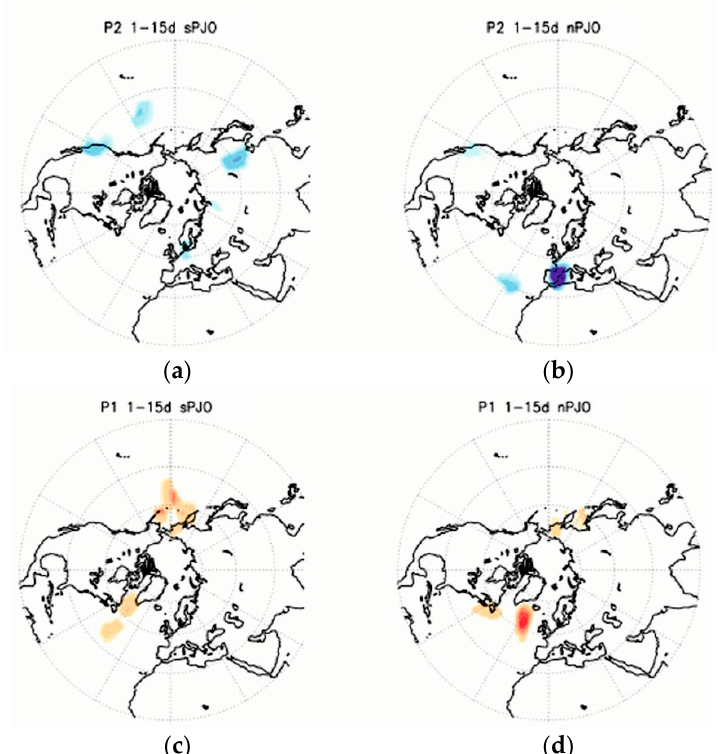
Figure 8. Mean composites of poleward Rossby wave breaking (i.e., RWB) events (m 2 /s 2 ) for strong-PJO ( a , c ) and non-PJO ( c , d ) events as a function of downstream ( a , b ) and upstream ( c , d ) breaking at upper troposphere for ERA-Interim. The mean was taken over 15 days after CD post phase. Shown are only significant patterns with 95% confidence. Details of the used RWB algorithm can be found in Reference [42].